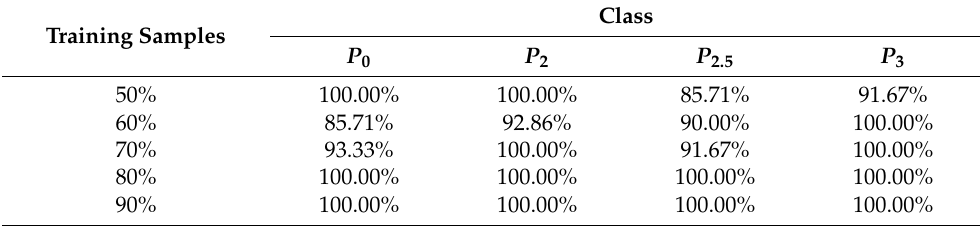
Table 2. The precision of the model.